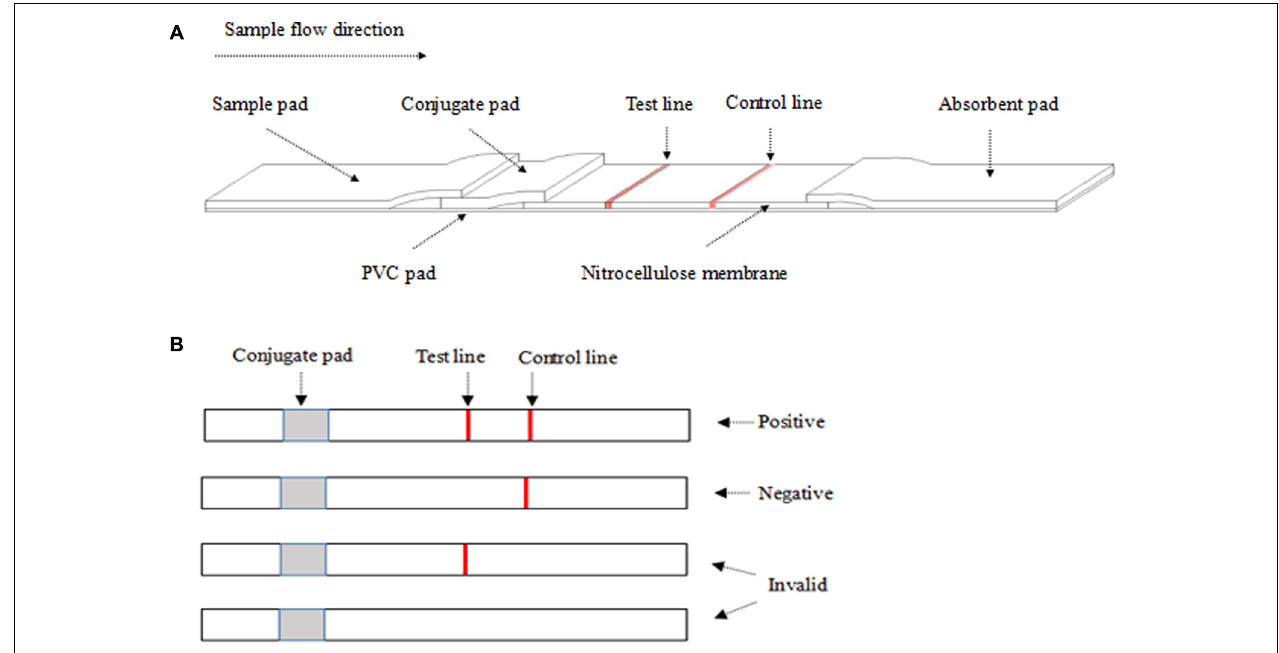
FIGURE 1 | The structure of the colloidal gold test strip (A) and the result from ICS (B) . (A) The liquid sample was added to the sample pad. The test line (polyclonal antibody C12D1) and control line (goat anti-mouse IgG antibody) were examined visually. (B) The appearance of two lines indicates a positive result, whereas a valid negative test produces only the control line.